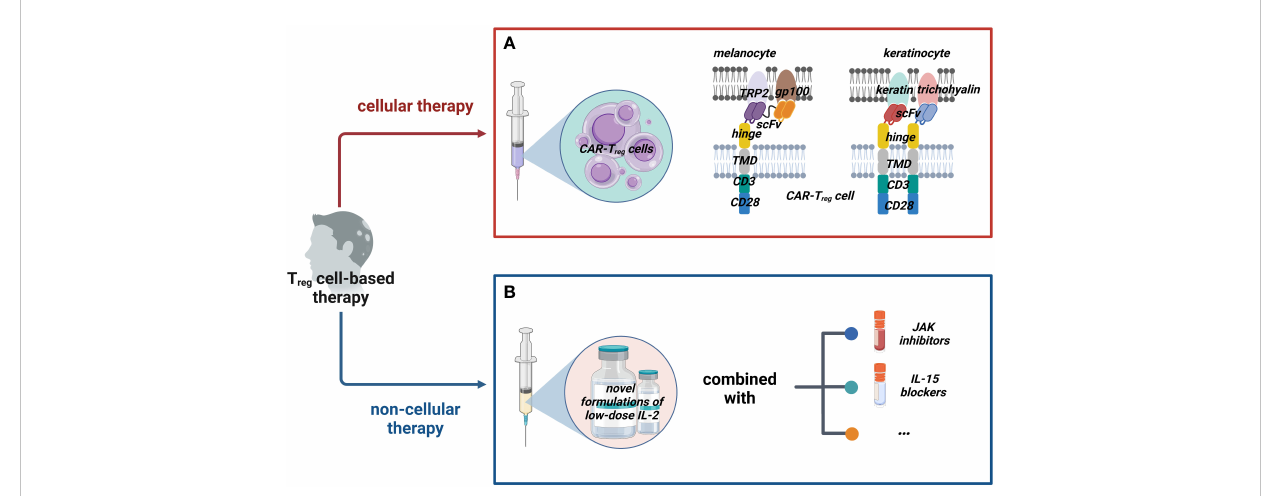
FIGURE 2 Possible T reg cell-based therapies for AA. We classi fi ed possible T reg cell-based therapy into two groups: cellular therapy and non-cellular therapy. (A) Cellular therapies such as adoptive transfer of CAR-T reg cells that could target dual (or multiple) potential antigens on melanocytes and keratinocytes with appropriate costimulatory domains should be tried. (B) Non-cellular therapies mainly work by inducing T reg cells; novel formulations of IL-2 are constantly being developed and they could be combined with other drugs such as JAK inhibitors and IL-15 blockers to enhance the ef fi cacy. (Figure2 created with